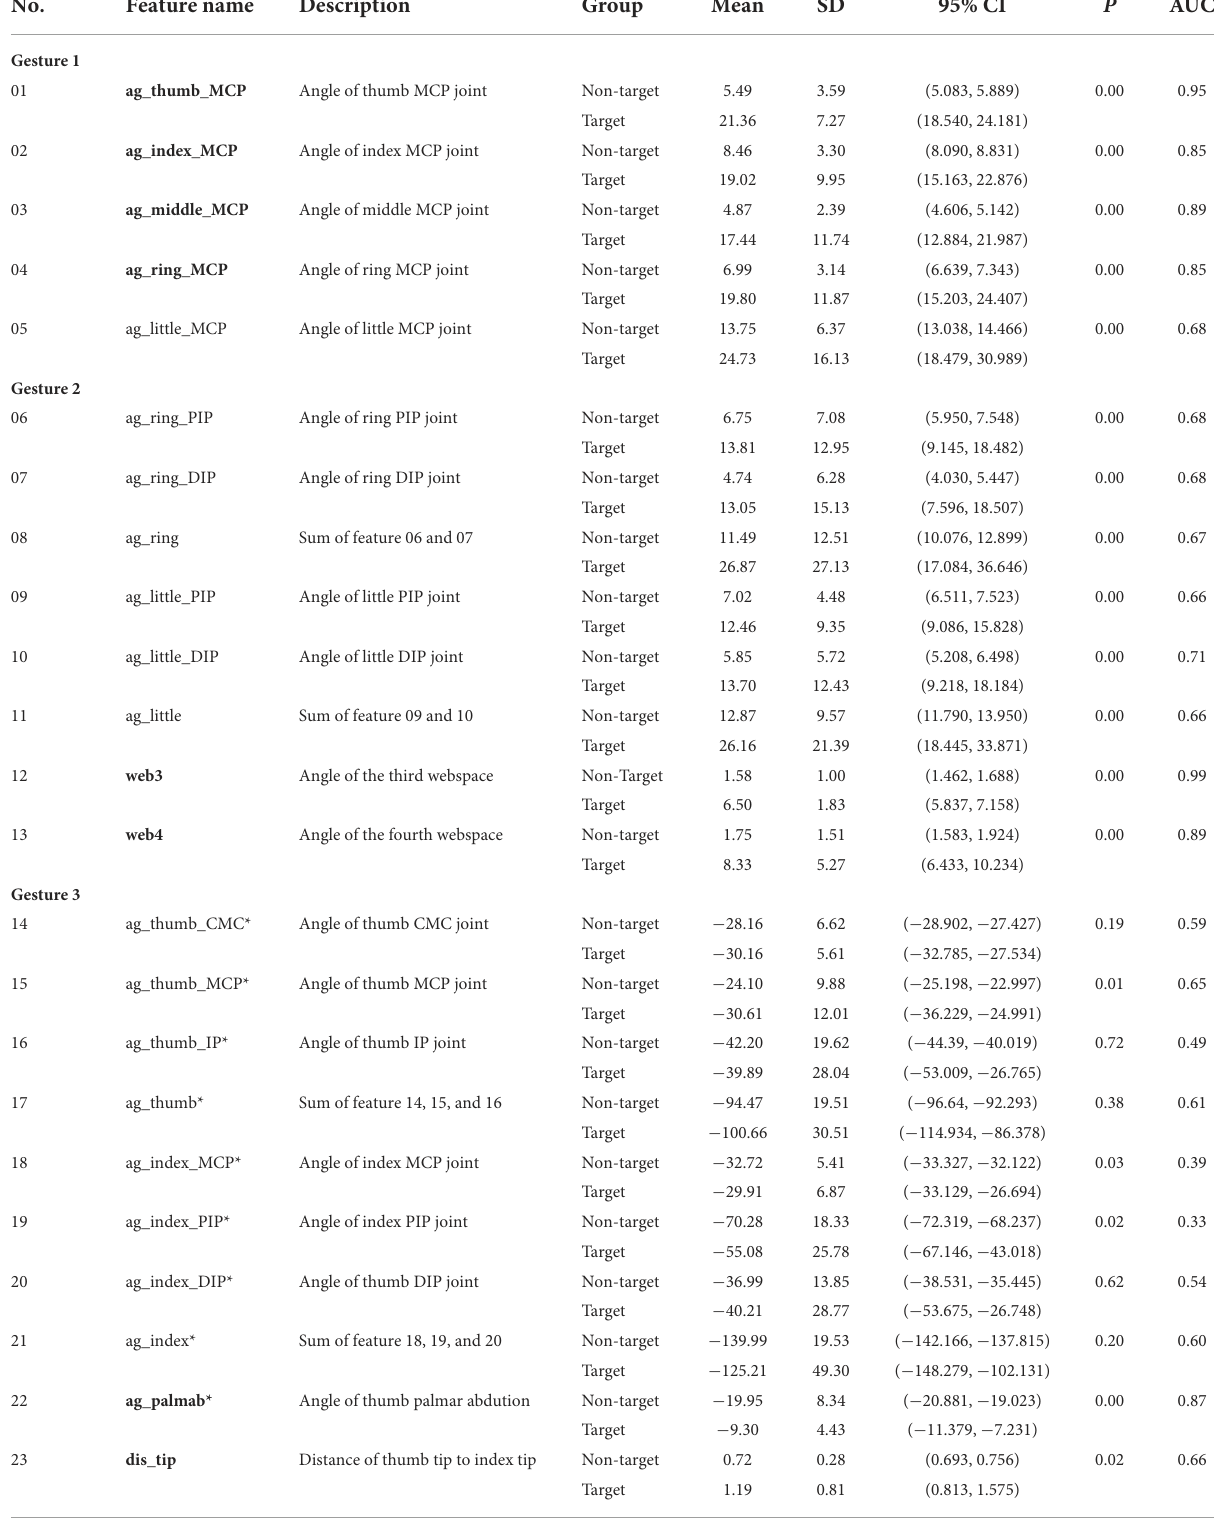
TABLE 1 Description and statistical analysis of the predetermined